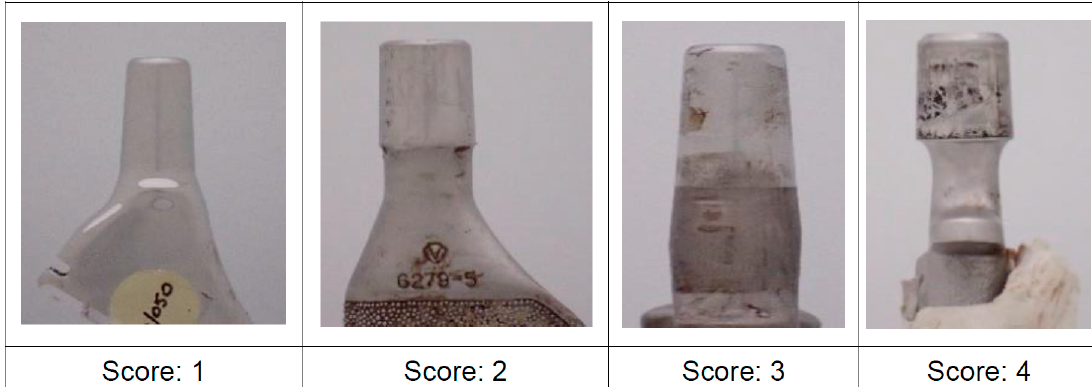
Figure 1. Corrosion damage scores of 1 through 4 for stem tapers.